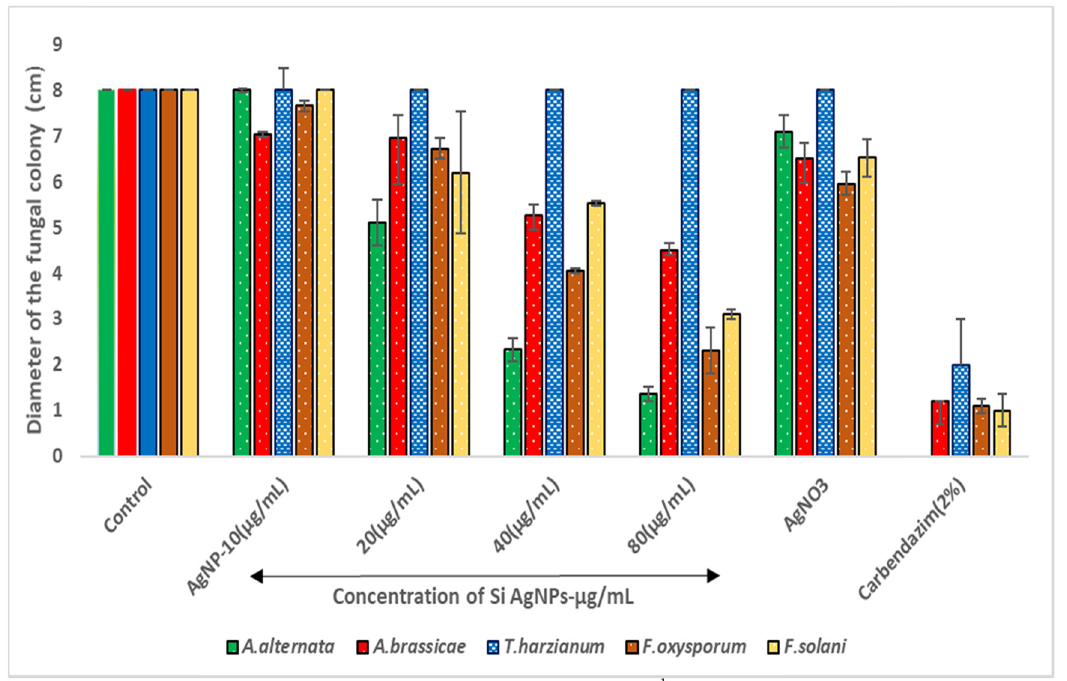
Figure 8: The e ff ect of various concentrations ( 10 – 80 µg · mL − 1 ) of Si - AgNPs on the mycelial growth of phytopathogenic